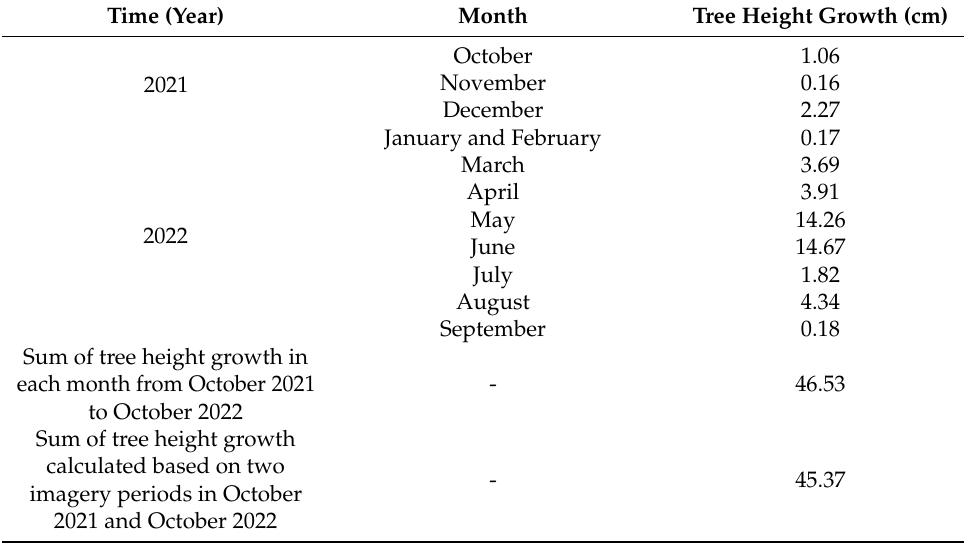
Table 4. Results of tree height growth in different months.